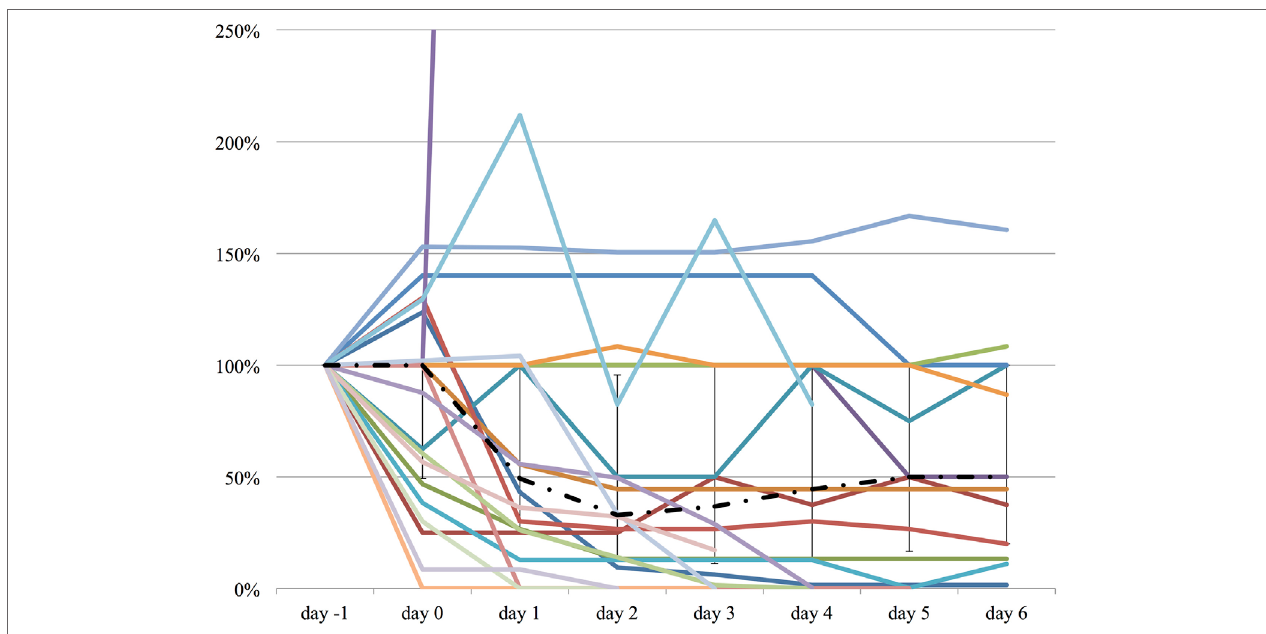
FigUrE 2 | The relative change in midazolam equivalent dose from day − 1 to day 6 . The vertical axis represents percent change of midazolam equivalent of each patient, compared to day − 1. The dashed line represents the median midazolam equivalent dose, and the range represents the interquartile